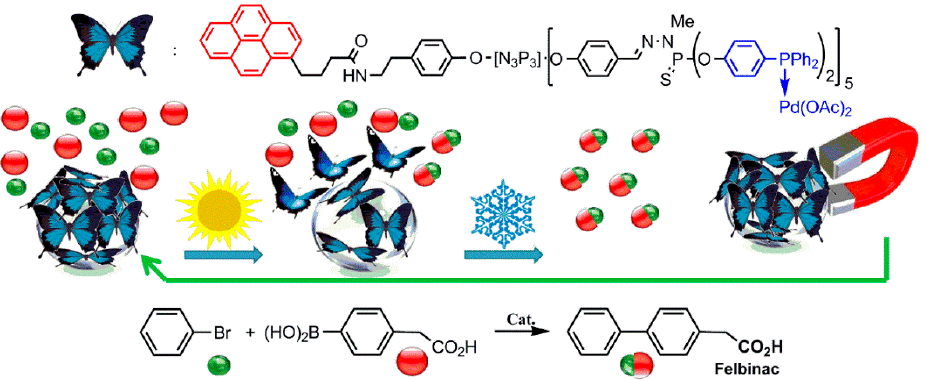
Figure 5. Dendrimer having a pyrene linked off-center to the core and palladium complex of phosphines as terminal groups. Illustration of the interaction of the pyrene at room temperature with the graphene layer covering cobalt nanoparticles. The dendrimers/Co nanoparticles are easily recovered using a magnet, to be reused in a new catalytic cycle. Illustration for the synthesis of felbinac. Having one function emanating from the core different from all the other functions is also a useful concept in the field of materials. Dendrimers with a triethoxysilyl group linked to the core and Boc-protected amines were synthesized for the functionalization of porous silica [33] in view of trapping CO 2 after deprotection of the amines. Also related to materials, but with an application in biology, dendrimers with a dithiolane group linked to the core and either positively charged ammoniums or negatively charged carboxylates as terminal groups were grafted to gold surfaces via the dithiolane function (Figure 6). The functionalized surfaces were used for cultures of human osteoblasts (responsible for the building of bones). The positively charged surfaces induced the death of osteoblasts, whereas the negatively charged surfaces induced the multiplication of the osteoblast [34]. However, only